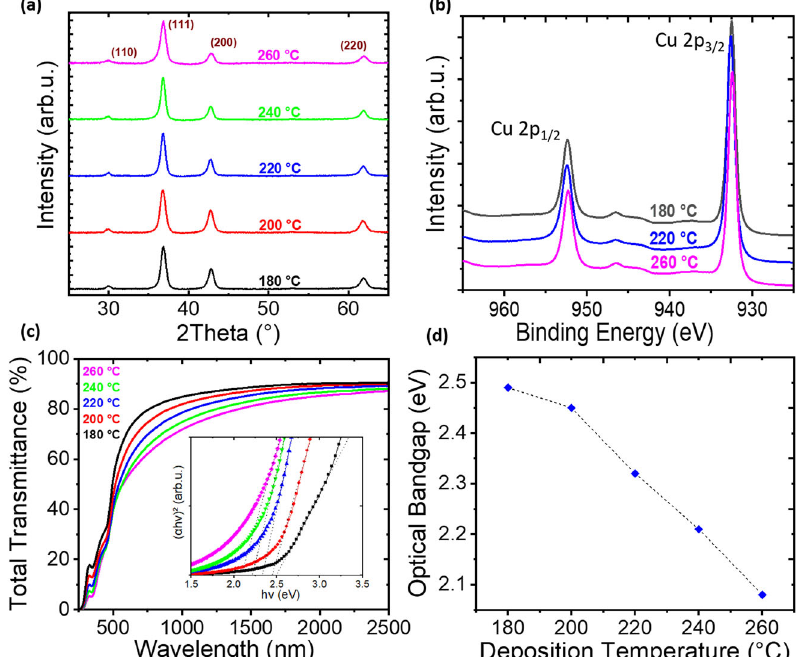
Fig. 3 Structural, chemical, and optical characterization. a GI-XRD patterns, b XPS spectra ( Cu 2p region), c total transmittance and Tauc plot measurement (inset, extracted from transmittance and re fl ectance spectra), and d direct optical bandgap values of Cu 2 O thin fi lms deposited at different temperatures on borosilicate glass substrates. (Re fl ectance data are reported in Supplementary Fig.